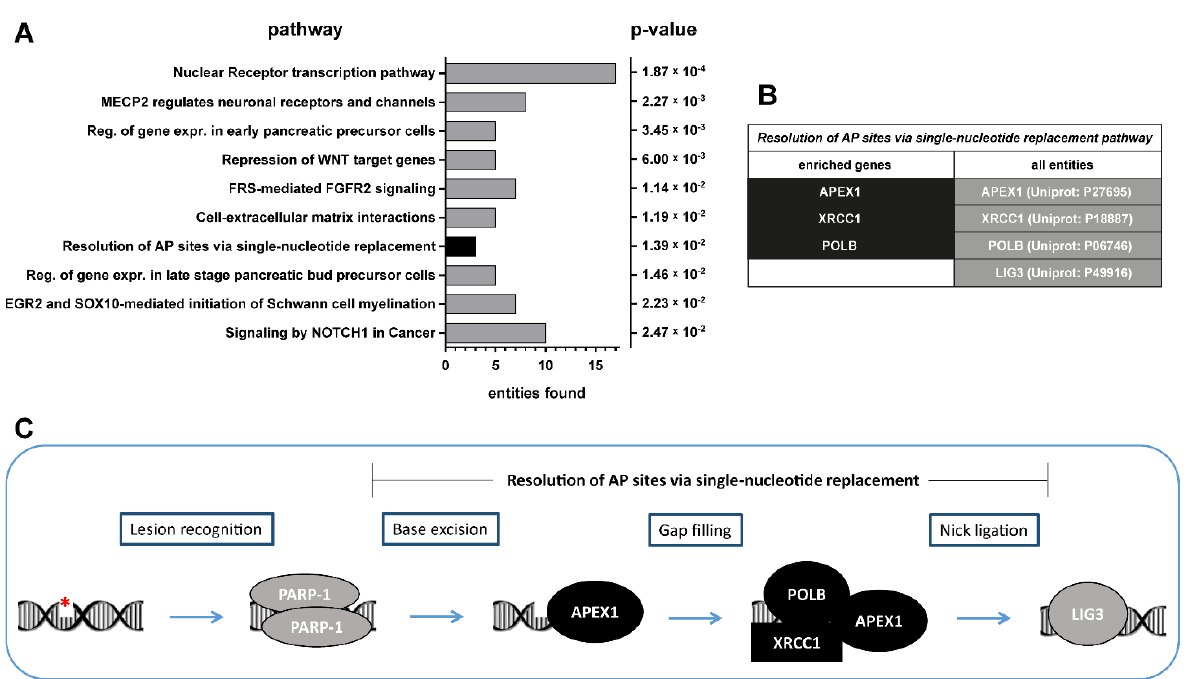
Figure 1. DNA repair pathways confer resistance to Palbociclib treatment. ( A ) The top 10 molecular processes identified by Reactome pathway analysis with sgRNA candidates. ( B ) A comparison of enriched genes conferring resistance to Palbociclib with all entities of the DNA repair process of apurinic/apyrimidinic (AP)-site resolution via single-nucleotide replacement pathway. ( C ) Model of DNA repair via the single-nucleotide replacement pathway. (MECP2: Methyl-CpG-binding protein 2, WNT: Int/Wingless family, FGFR2: Fibroblast growth factor receptor 2, FRS: FGFR substrate, AP: apurinic/apyrimidinic, EGR2: Early growth response protein 2, SOX10: Transcription factor SOX-10, NOTCH1: Neurogenic locus notch homolog protein 1, APEX1: DNA-AP endonuclease, POLB: DNA polymerase beta, XRCC1: X-ray repair cross-complementing protein 1, LIG3: DNA ligase 3).